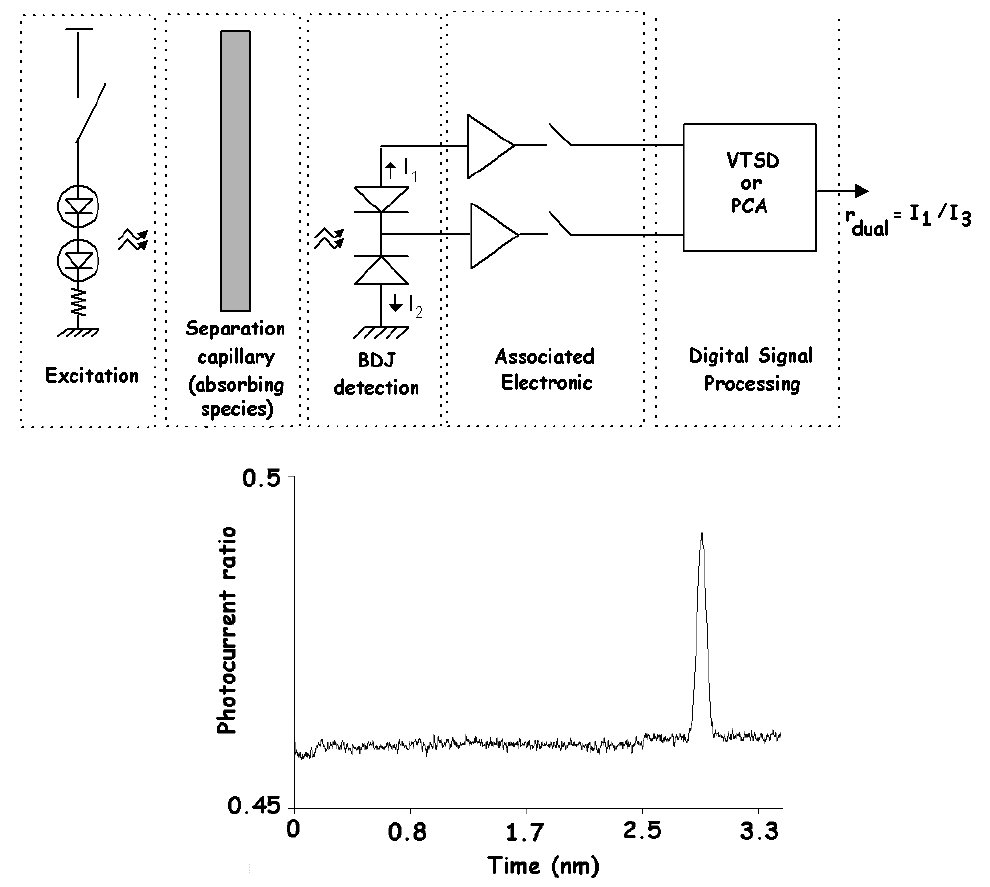
Figure 20. Capillary absorptiometric measurement with dual-wavelength method